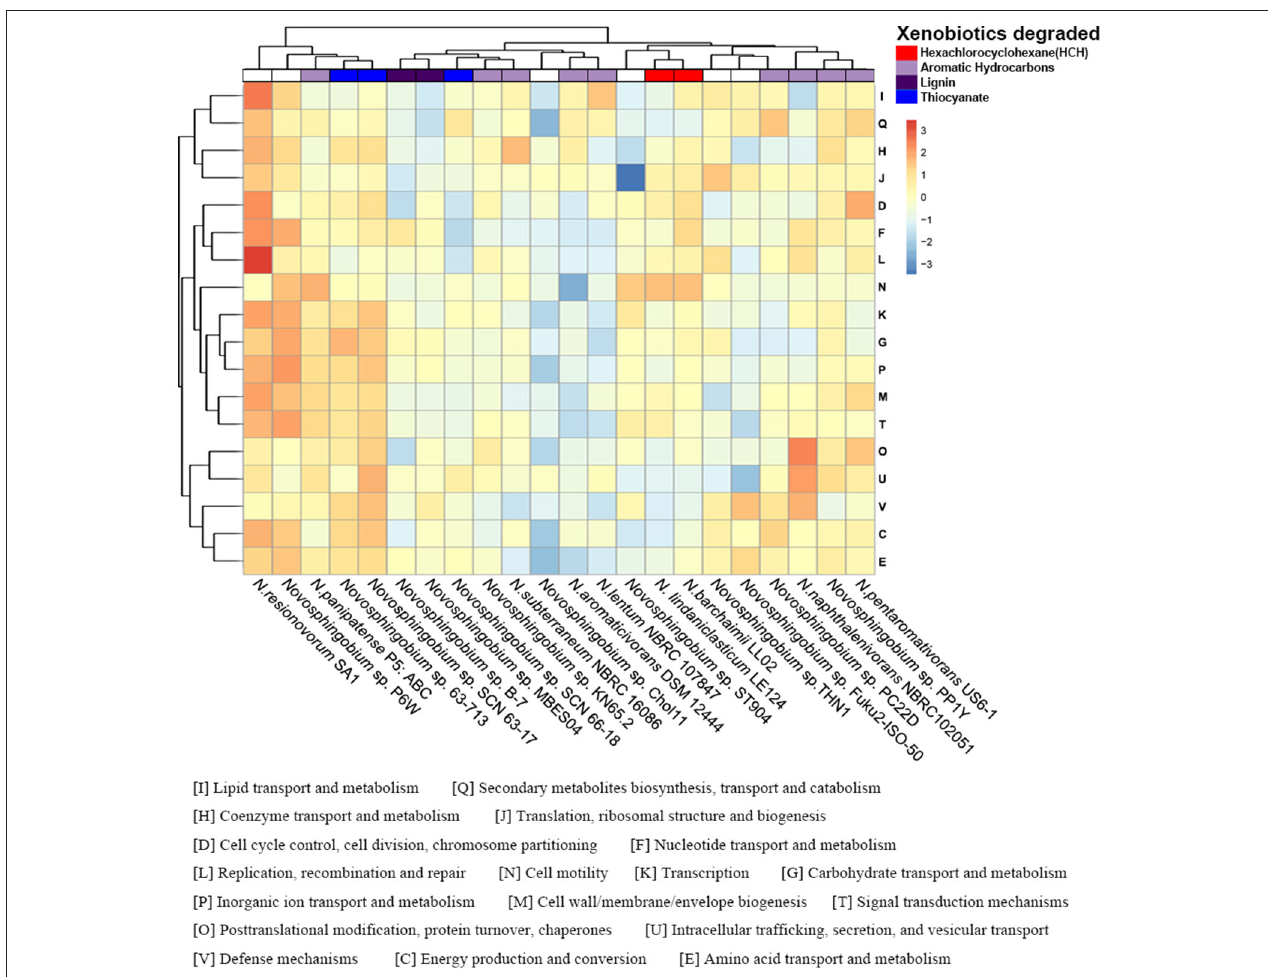
FIGURE 3 | Functional profiling of the Novosphingobium genomes. Heatmap showing the normalized relative abundance of the clusters of orthologous groups (COG) categories enriched in the protein-coding genes in the 22 Novosphingobium genomes. The strains and COG categories were clustered using the Euclidean distance. The color scale represents the relative abundance of gene content for each category, normalized by sample